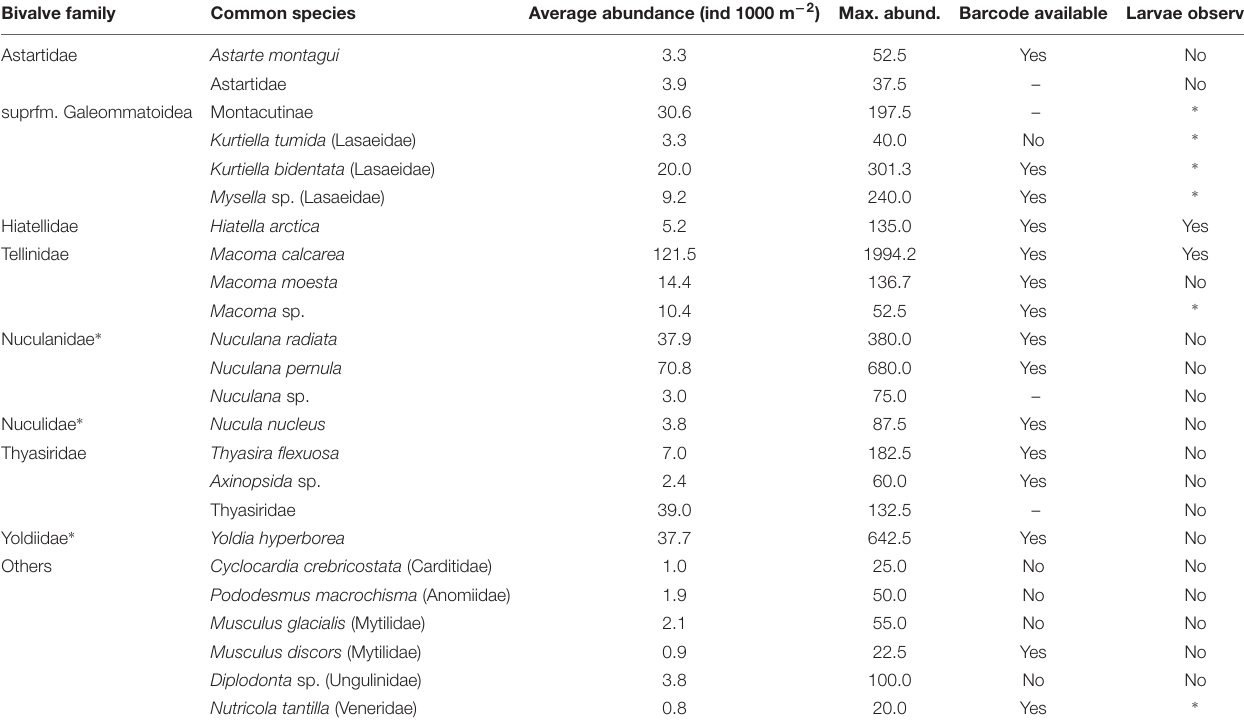
TABLE 4 | Most abundant adult bivalve species within the infauna of the Chukchi Sea. Bivalve